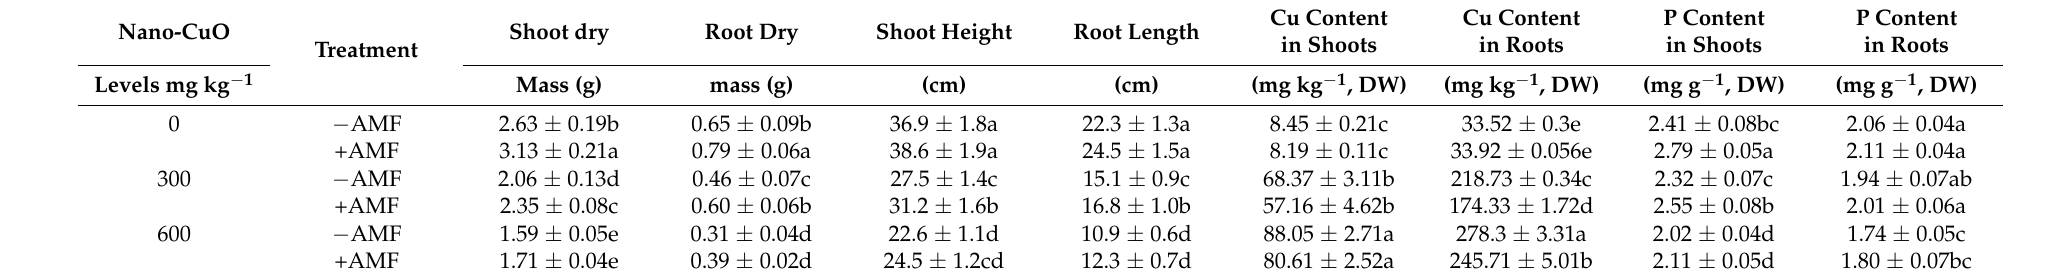
Table 1. Effects of AMF on the biomass, the Cu content, and the P content in tissues of C. indica seedlings under nano-CuO